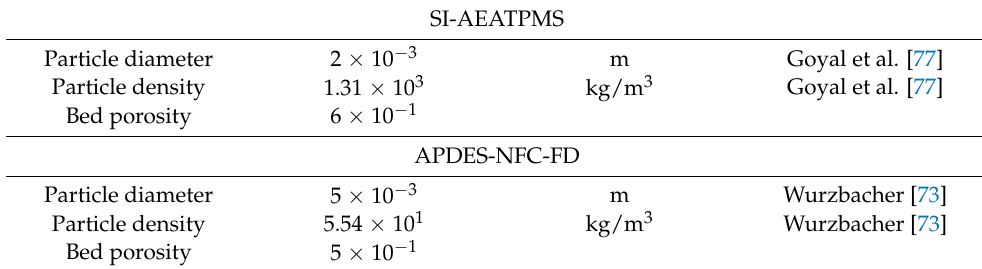
Table 5. Main data for amine-functionalized sorbents.